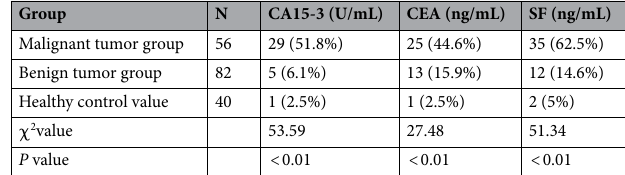
Table 3. Positive expression rate of CA15-3, CEA and SF in serum. P < 0.01 show extremely significant difference by χ 2 test.